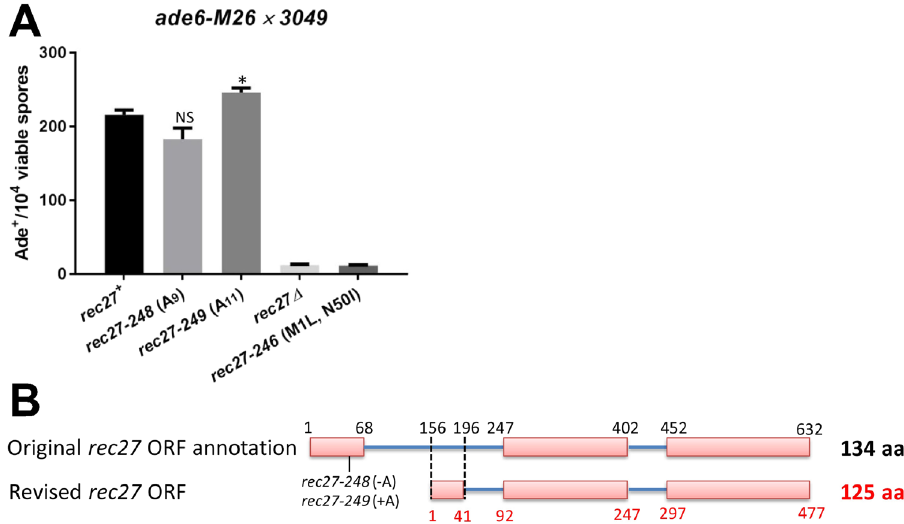
Figure 3. Revised Rec27 ORF starts within the first formerly designated intron. ( A ) Meiotic recombination between ade6-M26 and ade6-52 in rec27 mutants. Data (mean ± SEM) are from Supplementary Table S3; n = 4 for each strain. NS (non-significant) and * (P < 0.05) indicate significance of the difference from rec27 + by unpaired t-test. ( B ) Map of revised rec27 ORF (lower line) compared to the previous annotation (upper line) (http://www.pombase.org/spombe/result/SPBC577.05c). Pink boxes are exons.